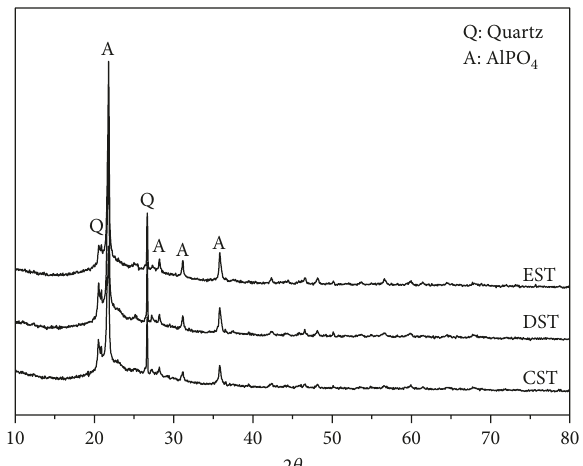
Figure 12: X-ray diffraction patterns of the PAG-solidified CST, DST, and EST samples.